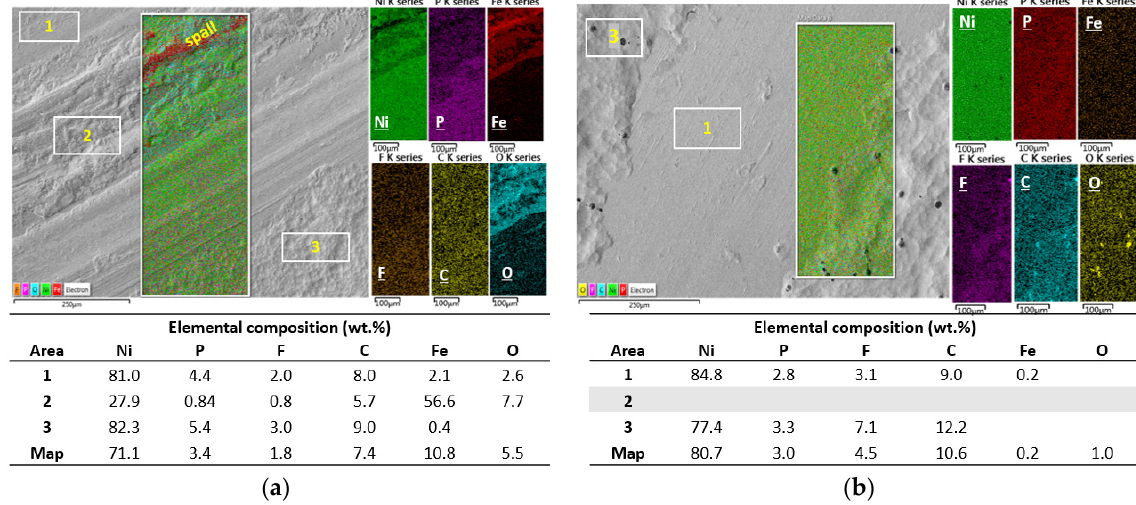
Figure 15. SEM morphology of wear surfaces and EDS maps of the worn zones of the developed ENP+PTFE: ( a ) ENP1 and ( b ) ENP3 duplex coatings at 10 N load for a duration of 1 h-12,000 cycles.